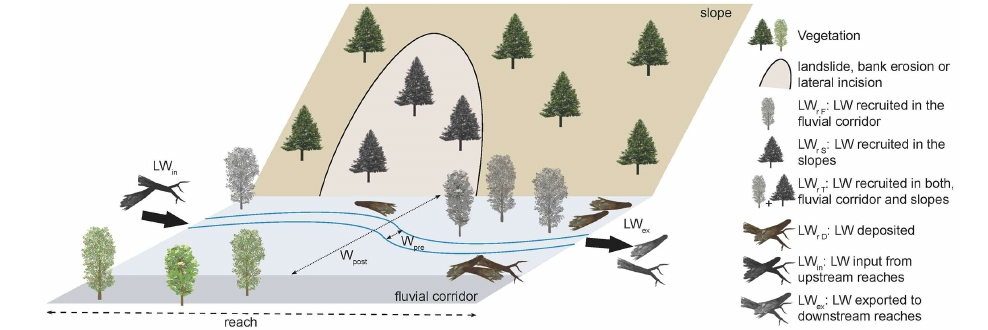
Figure 5. Conceptual model of the LW and morphological dynamics in a studied reach.